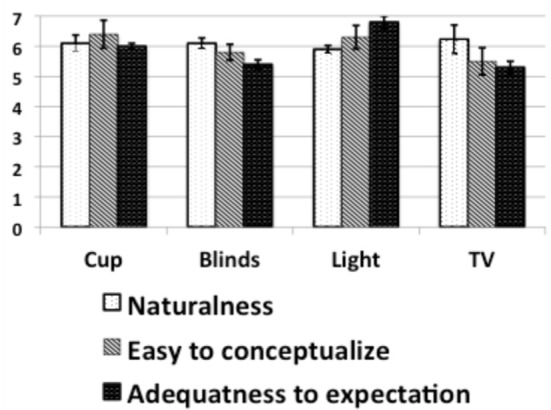
Averaged answers given by users about the naturalness of the action, the easiness of conceptualization and the adequateness to expectation on a scale from 1 to 7. The error bars are the 95% confidence interval.